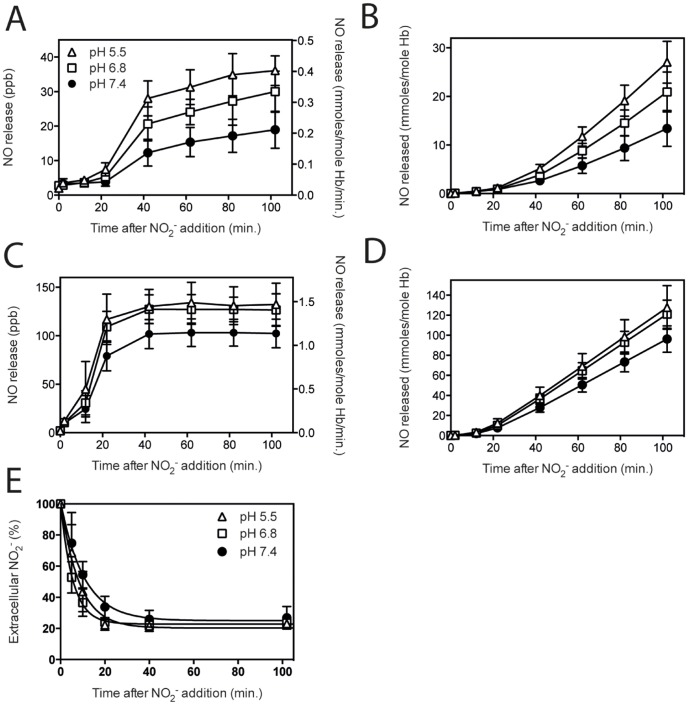
Decreased pH leads to increased nitrite-to-NO reduction.Clinical severe acidosis and tissue ischema was mimicked by incubation of RBC and hemolysates in an environment with reduced pH. Under hypoxia and after addition of 5-mediated NO-release showed a pH-dependent increase. A lower pH resulted in an increased NO release rate (A & C) and therefore total release in time (B & D). Nitrite influx into RBC was also affected by lowering the pH. Both pH 6.8 and pH 5.5 demonstrated a slightly faster nitrite transport into RBC (E). A & B: RBC pH 5.5 n = 3, Hb 11.7±0.3, pH 6.8 n = 3, Hb 11.6±0.1 g/dL, pH 7.4 n = 32, Hb 11.6±0.4, C & D: Hemolysates pH 5.5 n = 4, Hb 11.7±0.2, pH 6.8 n = 4, Hb 11.8±0.2, pH 7.4 n = 29, Hb 11.6±0.3, E: influx curve fits: pH 5.5 y = 20.3+81.3*exp(−0.121*t); R2 = 0.990, pH 6.8 y = 22.8+77.0*exp(−0.182*t); R2 = 0.999, pH 7.4 y = 25.0+76.2*exp(−0.095*t); R2 = 0.996 Statistics: RBC NO release rate: pH 7.4 vs. pH 6.8; *** after 42 and 62 minutes, **** after 82 and 102 minutes, pH 7.4 vs. pH 5.5; **** after 62–102 minutes, 6.8 vs. 5.5; * after 42–82 minutes. RBC total NO release: pH 7.4 vs. pH 6.8; * after 62 minutes, **** after 82 and 102 minutes, pH 7.4 vs. pH 5.5; **** after 62–102 minutes, 6.8 vs. 5.5; ** after 82 minutes, **** after 102 minutes. Hemolysate NO release rate: pH 7.4 vs. pH 6.8; *** after 22 minutes and ** after 42–102 minutes, pH 7.4 vs. pH 5.5; * after 12 minutes, **** after 22 and 62 minutes, *** after 42, 82 and 102 minutes. Hemolysate total NO release: pH 7.4 vs. pH 6.8; *** after 62 minutes, **** after 82 and 102 minutes, pH 7.4 vs. pH 5.5; ** after 42 minutes, **** after 62, 82 and 102 minutes. Influx: pH 5.5 vs. pH 6.8; * after 5 minutes, pH 6.8 vs. pH 7.4, **** after 5 minutes, and *** after 10 minutes. *P<0.05, **P<0.01, ***P<0.001, ****P<0.0001